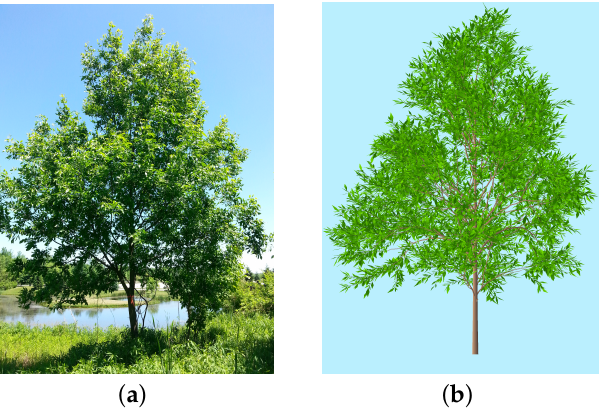
Figure 2. ( a ) an ash tree located within the Rochester Institute of Technology (RIT) campus and ( b ) its 3D